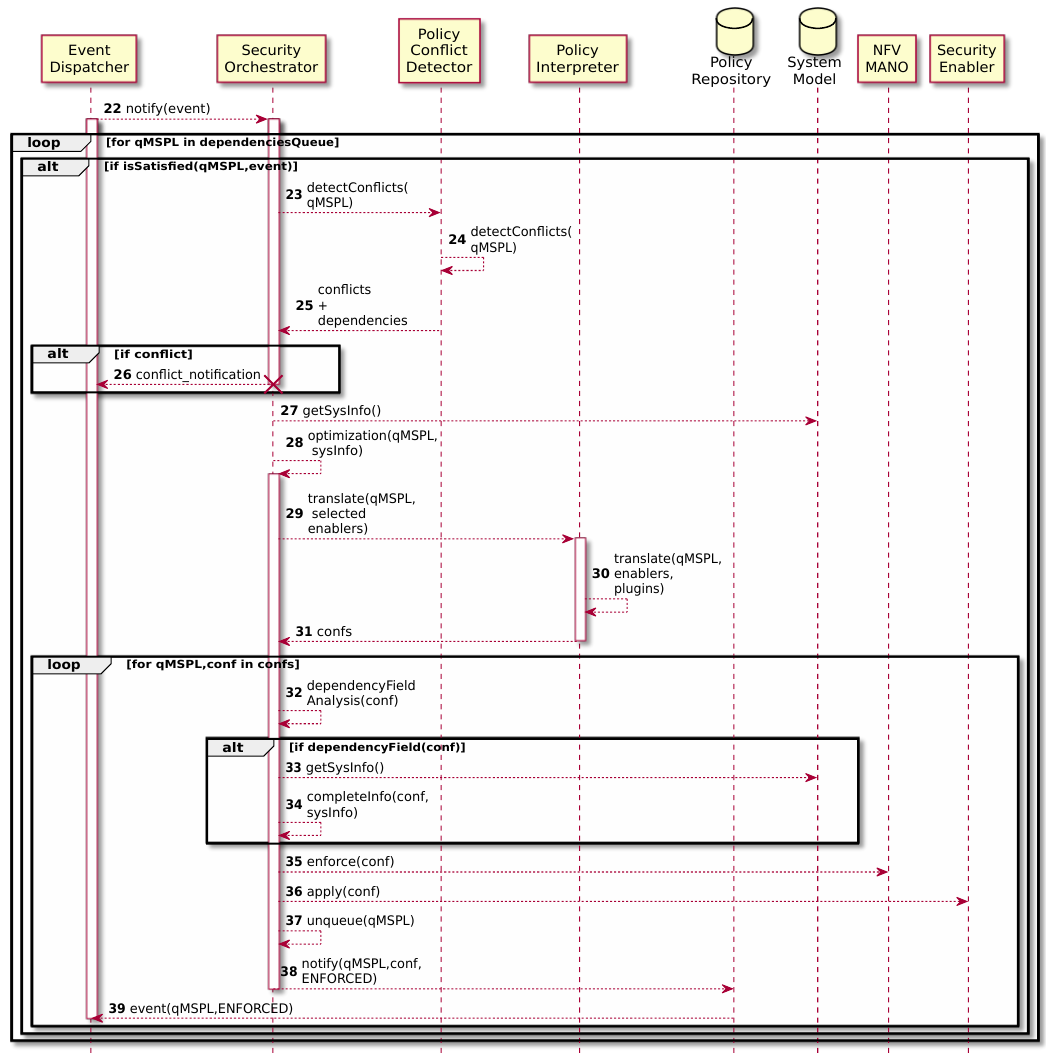
Figure 6. Dependencies management